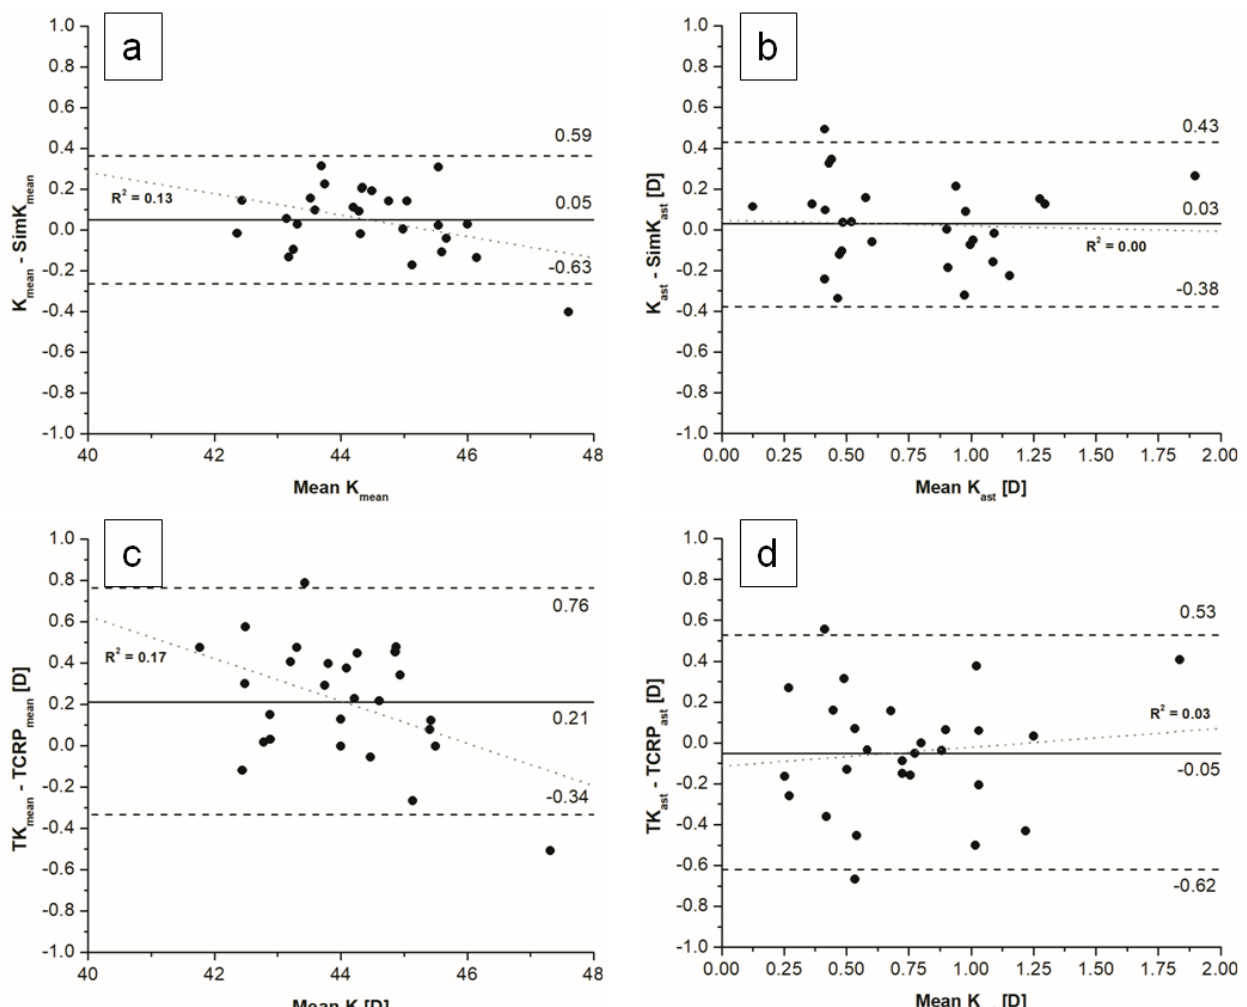
Figure 3. Bland–Altman plots of comparison between K and simK using ( a ) mean values, ( b ) astig- matism magnitude and for TK and TCRP using ( c ) mean values, ( d ) astigmatism magnitude. The difference between anterior and total astigmatism did not exceed a predefined clinically significant limit of 0.5 D for SS-OCT biometer in any of the analysed eyes. For the Scheimpflug SimK ast and TCRP ast , the 0.5 D difference was exceeded in 2 (7%) cases out of 29. The >0.5 D difference between TK ast and TCRP ast was noticed in 5 (17%) cases out of